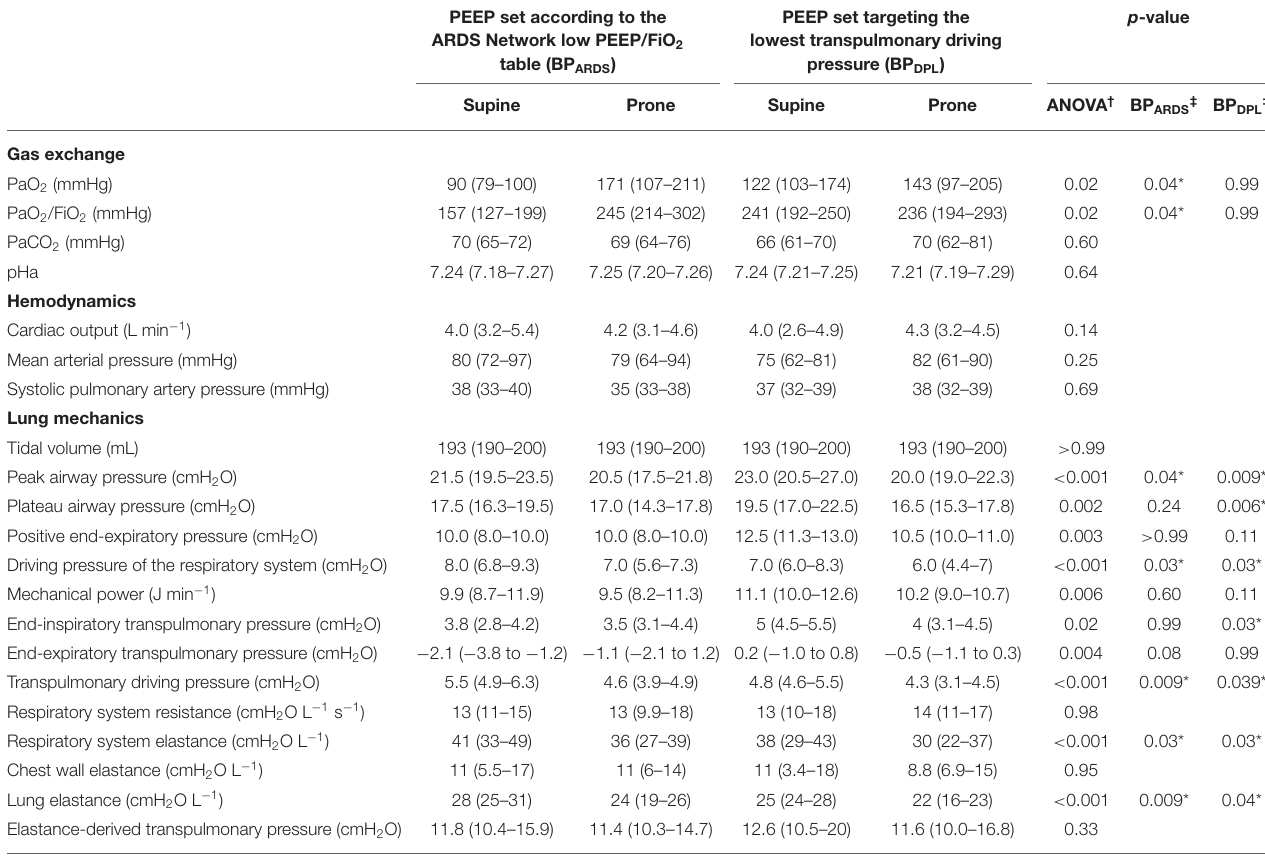
TABLE 1 | Gas exchange, hemodynamics, and lung mechanics parameters in prone and supine positions with the two PEEP titration strategies in 10 pigs.